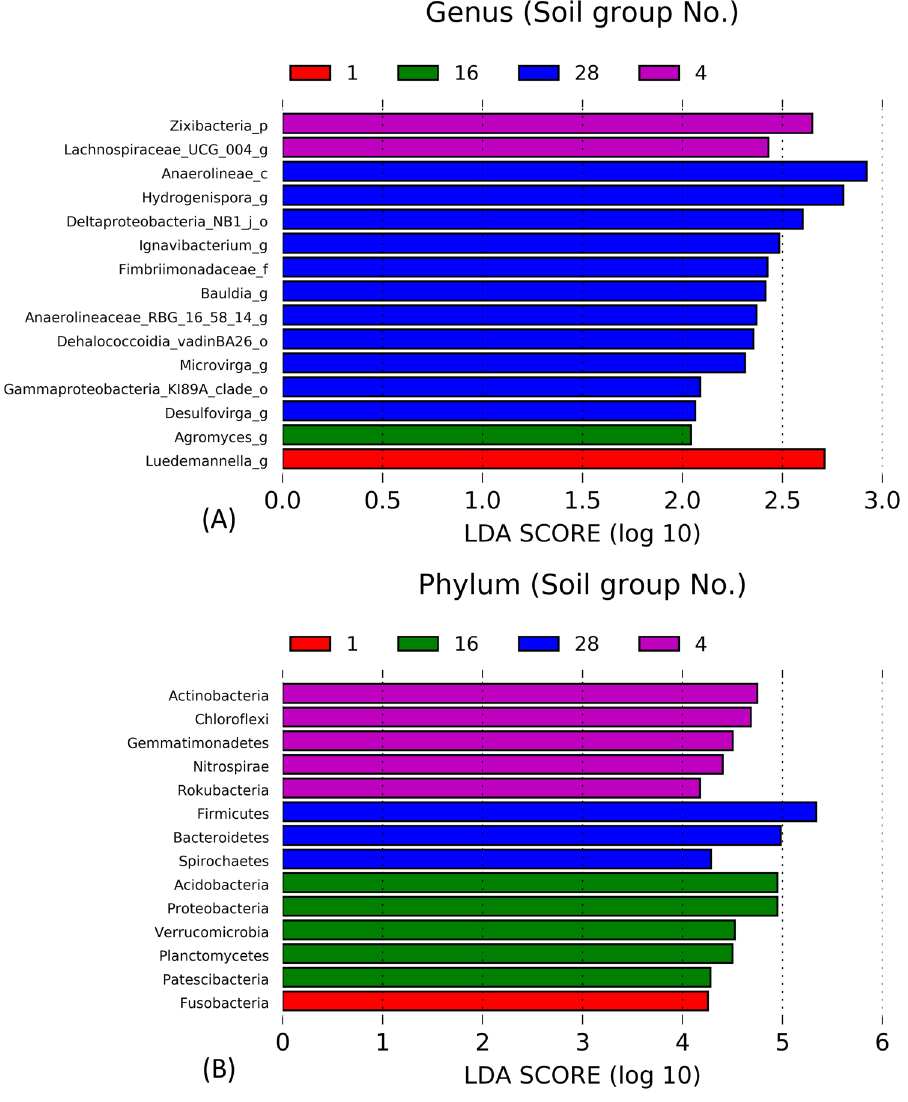
Figure 7. Differential abundance of bacterial communities at the genus ( A ) and phylum levels ( B ) (LDA score > 2) based on linear discriminant analysis (LDA) effect size (LEfSe) from different soil groups ( n = 30, p < 0.05). Each soil group No. is represented in red (No. 1), green (No. 16), blue (No. 28), and purple (No.